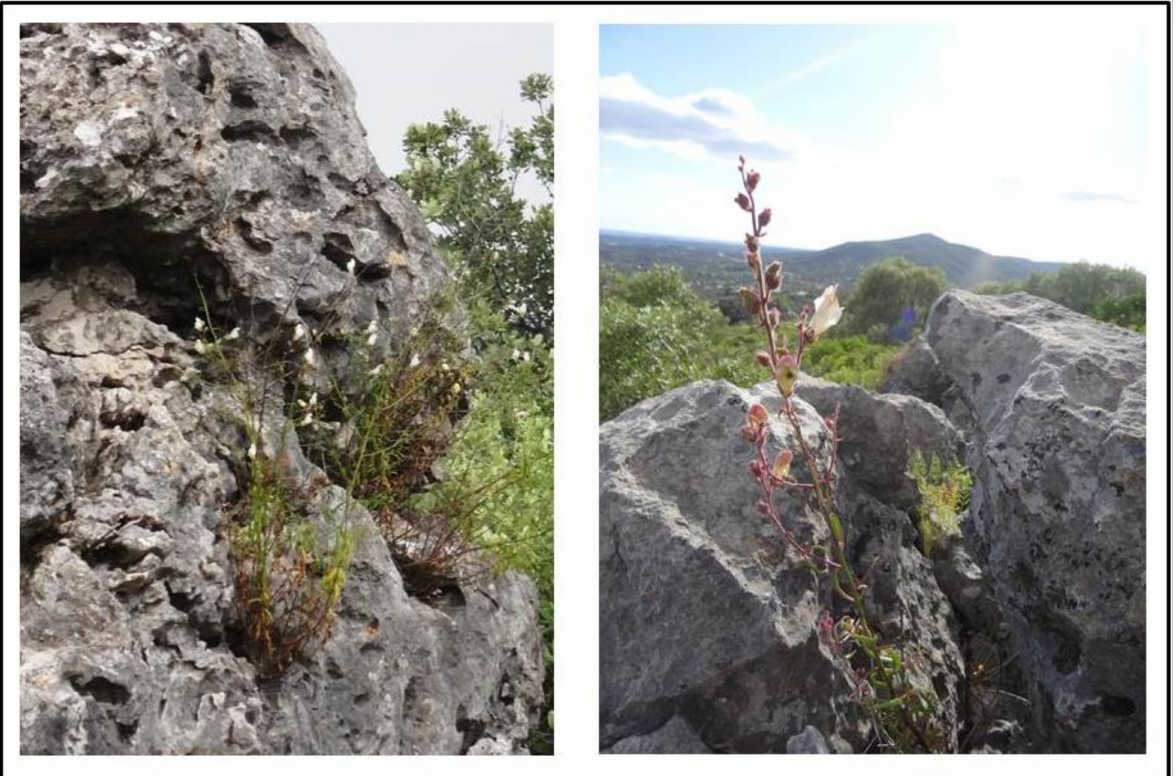
Figure 4. Antirrhinetum onubensis on rocky fissures of limestones in the Algarve and Monchique Sector—Barrocal algarvio (left: Varejota, Parragil—Loul é ; right: Cerro da Cabeça, Moncarapacho—Olh ã